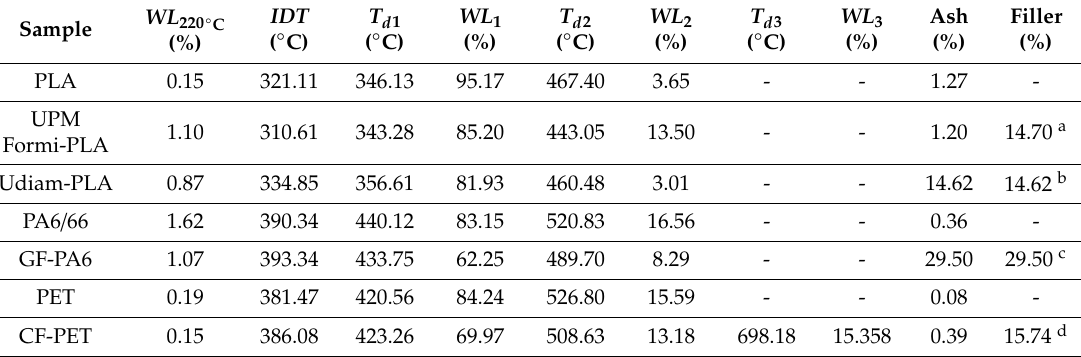
Figure 3. Thermogravimetric analysis representing ( a ) weight loss, inset (details up to 250 ° C) and ( b ) differential weight loss of different printing filaments. Table 2. Thermogravimetric analysis of di ff erent printing